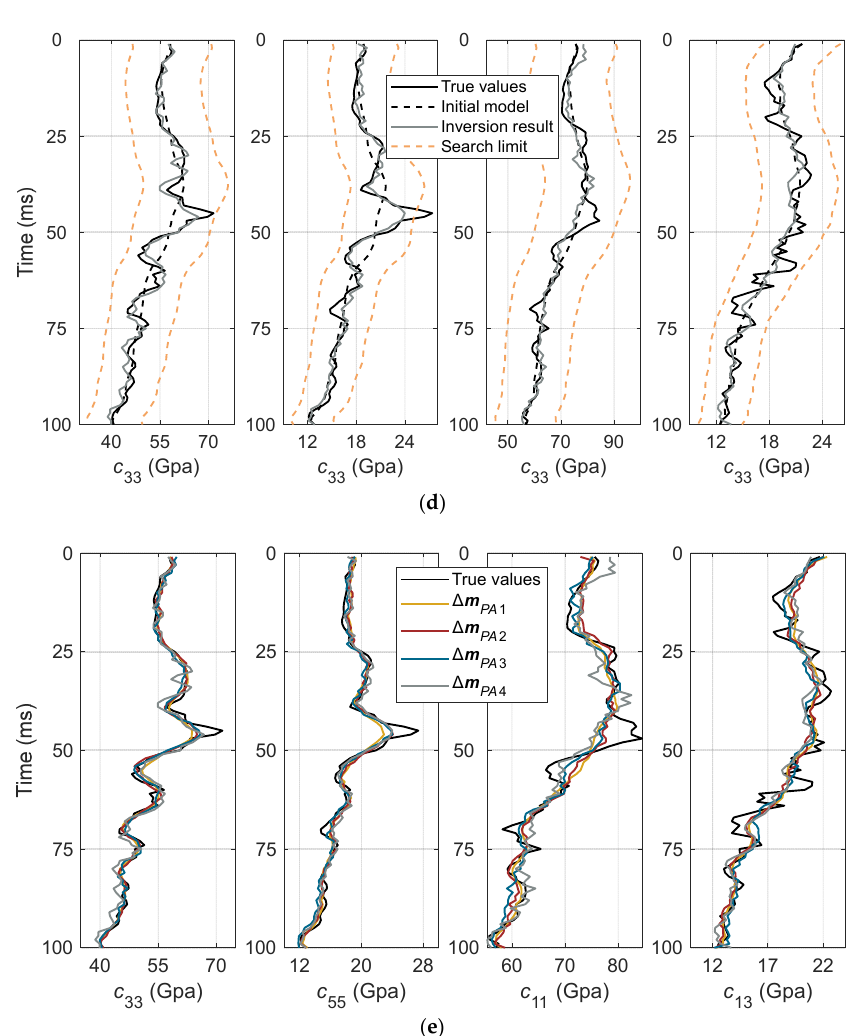
Figure 6. Inversion results with the well model by the FSA optimization at different perturbation ranges: ( a ) the perturbation range Δ m PA 1 , ( b ) the perturbation range Δ m PA 2 , ( c ) the perturbation range Δ m PA 3 , ( d ) the perturbation range Δ m PA 4 , and ( e ) the comparison of the four sets of results from ( a ) to ( d ). The perturbation ranges gradually increase from Δ m PA 1 to Δ m PA 4 . The black solid, black dash, and orange dash curves denote the true logs, the initial models, and the search limits, respectively. The de fi nitions of inverted curves are given in the legend.